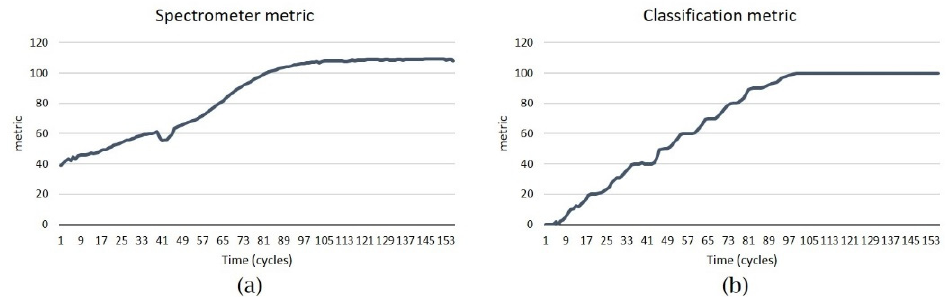
Figure 10. ( a ) Spectrometer metric in time and ( b ) classification metric in time (each point from the horizontal axis is the mean of 400 values collected during a cycle). The spectrometer and the classifier can be used instead of collecting samples from the decellularization solution and can estimate in real-time the decellularization state, thus optimizing the old